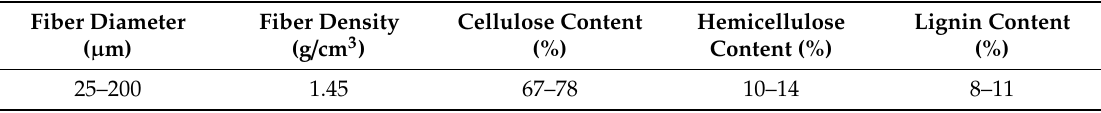
Table 1. Properties of sisal